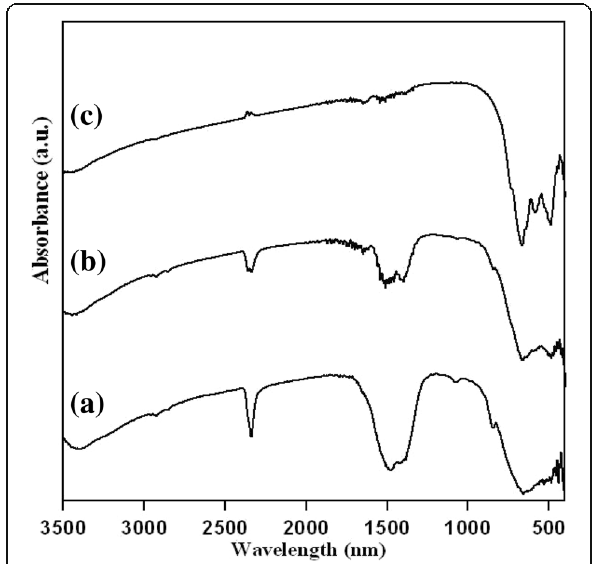
Fig. 3 The morphology of as-synthesized La 3 Ga 5.5 Nb 0.5 O 14 at 600 °C. The inset is the TEM images of nanofoam at the precursor ’ s